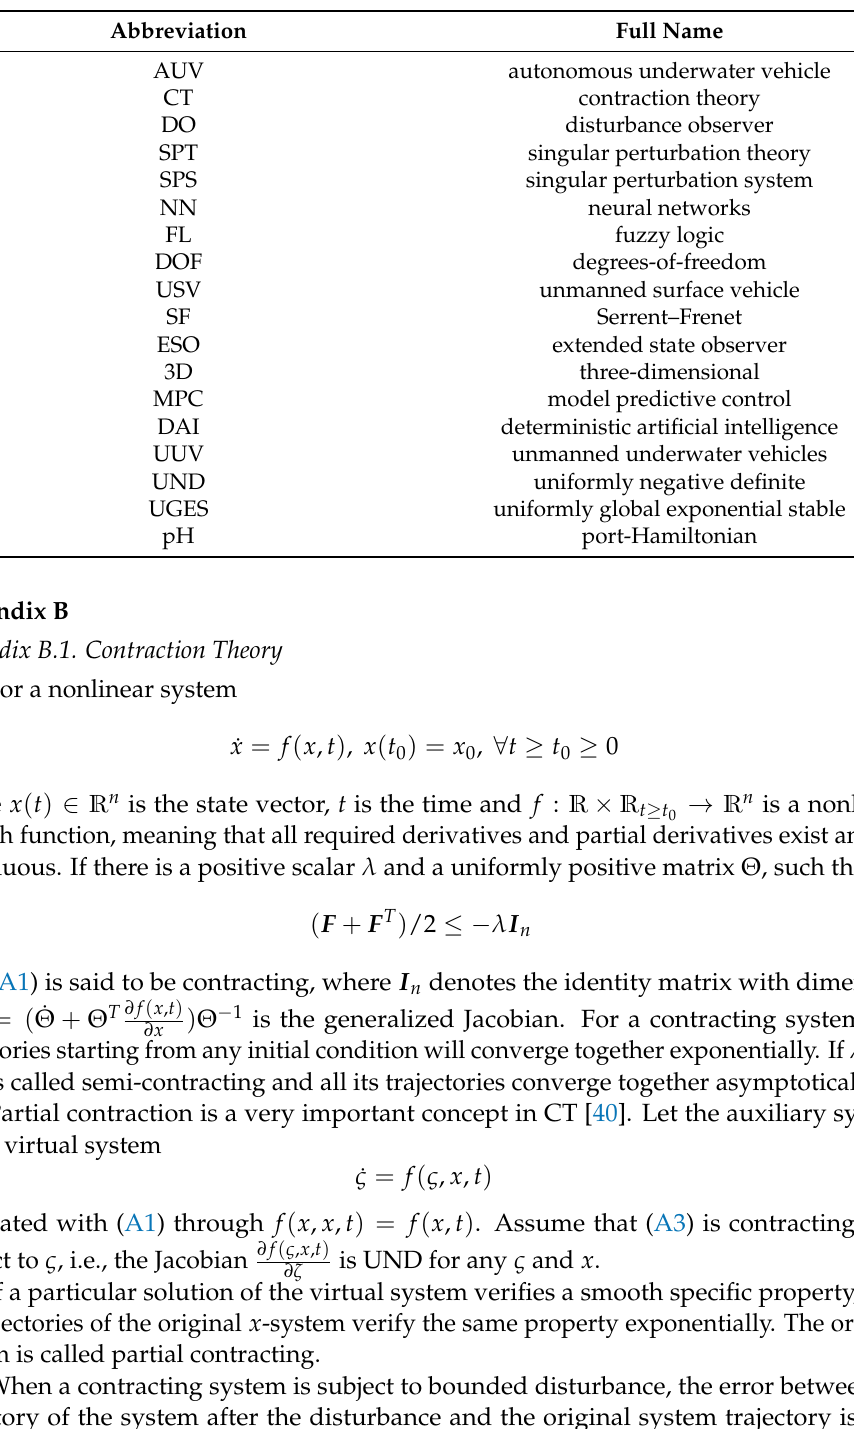
Table A1. The abbreviations used in this